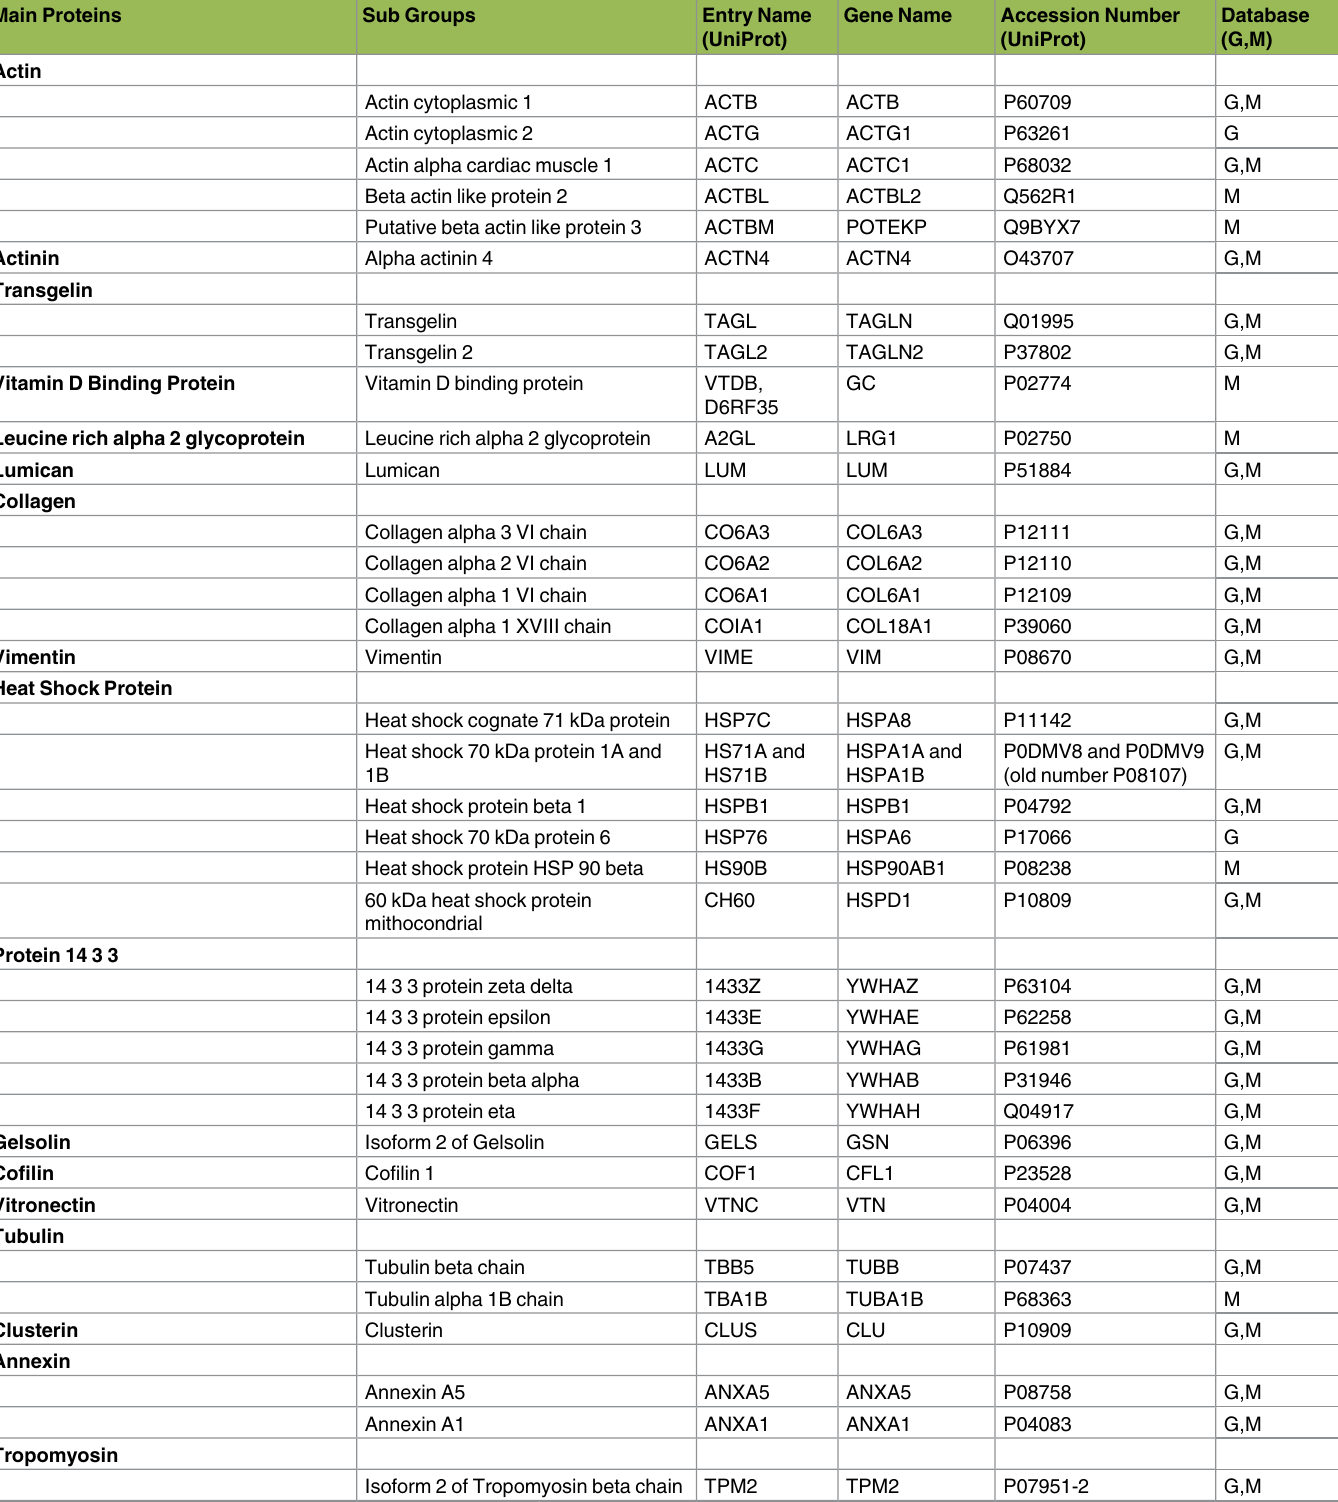
Table 1. Proteins and peptides belonging to kidney tissues detected from preservation solution using LC-MS/MS